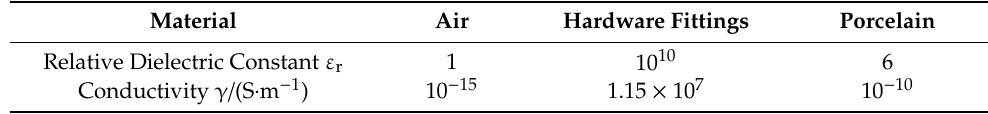
Figure 4. Insulator string simulation model.